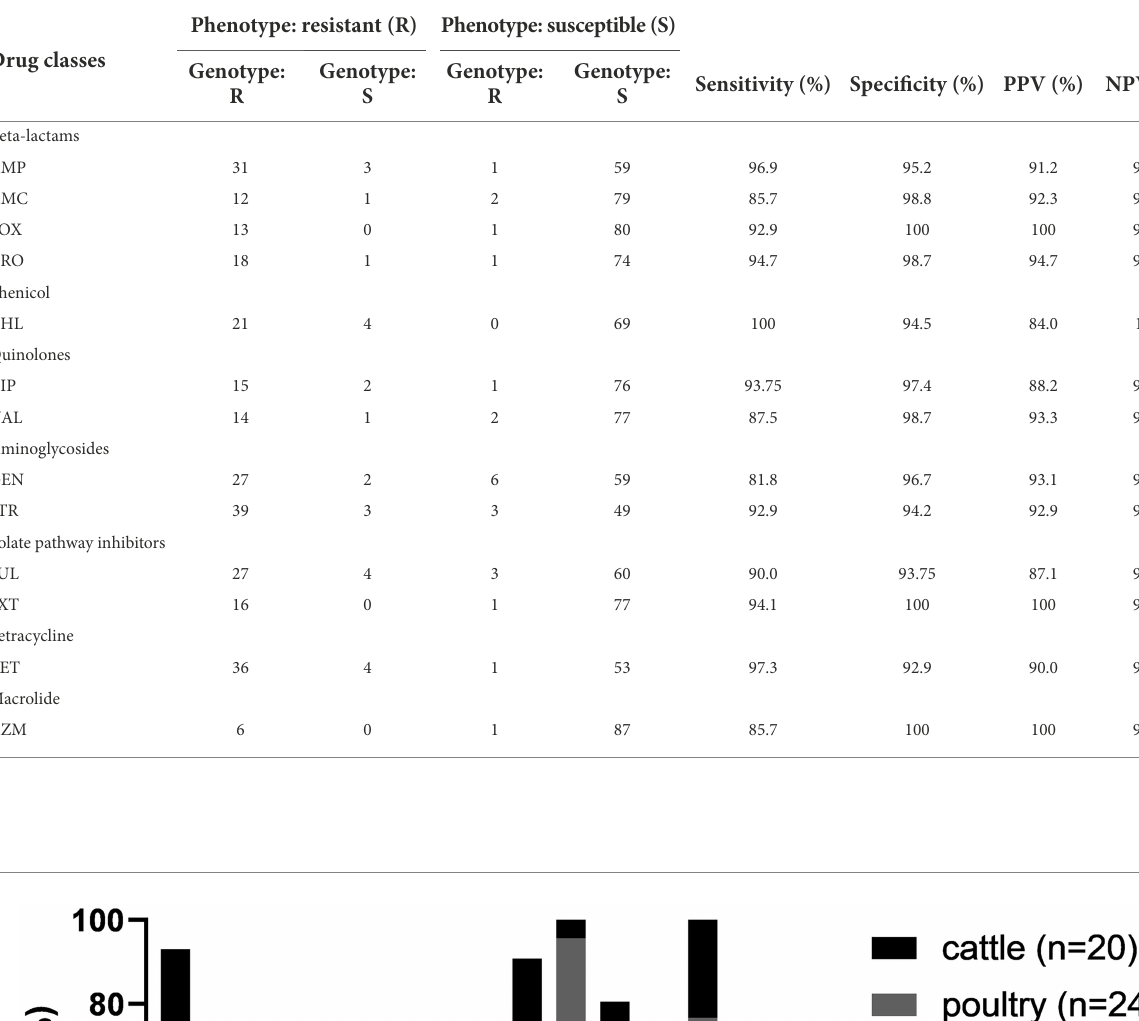
TABLE 3 Correlation of phenotype susceptibility and genotype.